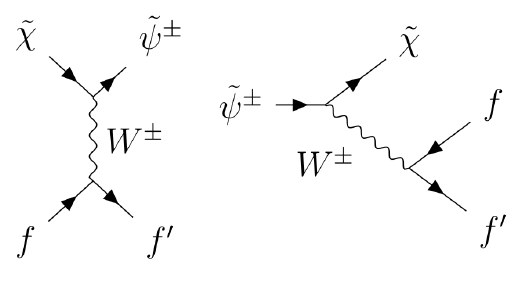
Figure 1: Dominant processes contributing to the co-scattering (left) and decay (right) terms in the STFM.